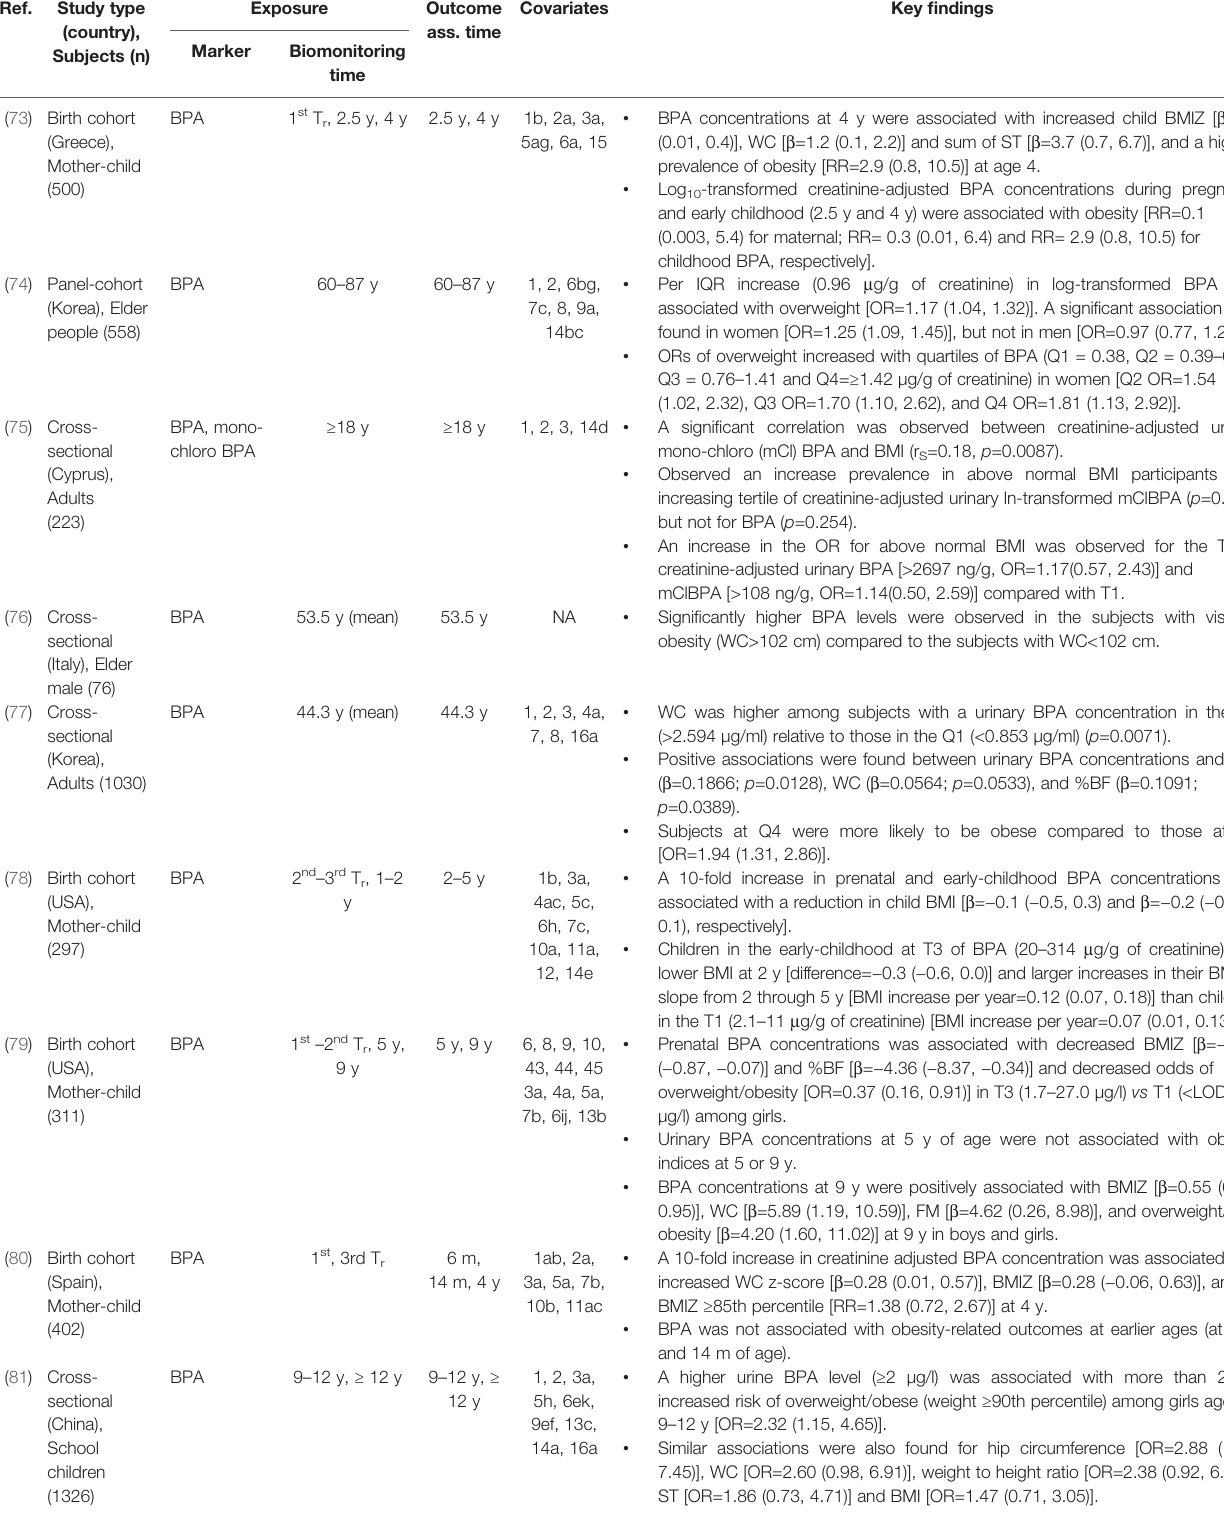
Similar associations were also found for hip circumference [OR=2.88 (1.12, 7.45)], WC [OR=2.60 (0.98, 6.91)], weight to height ratio [OR=2.38 (0.92,